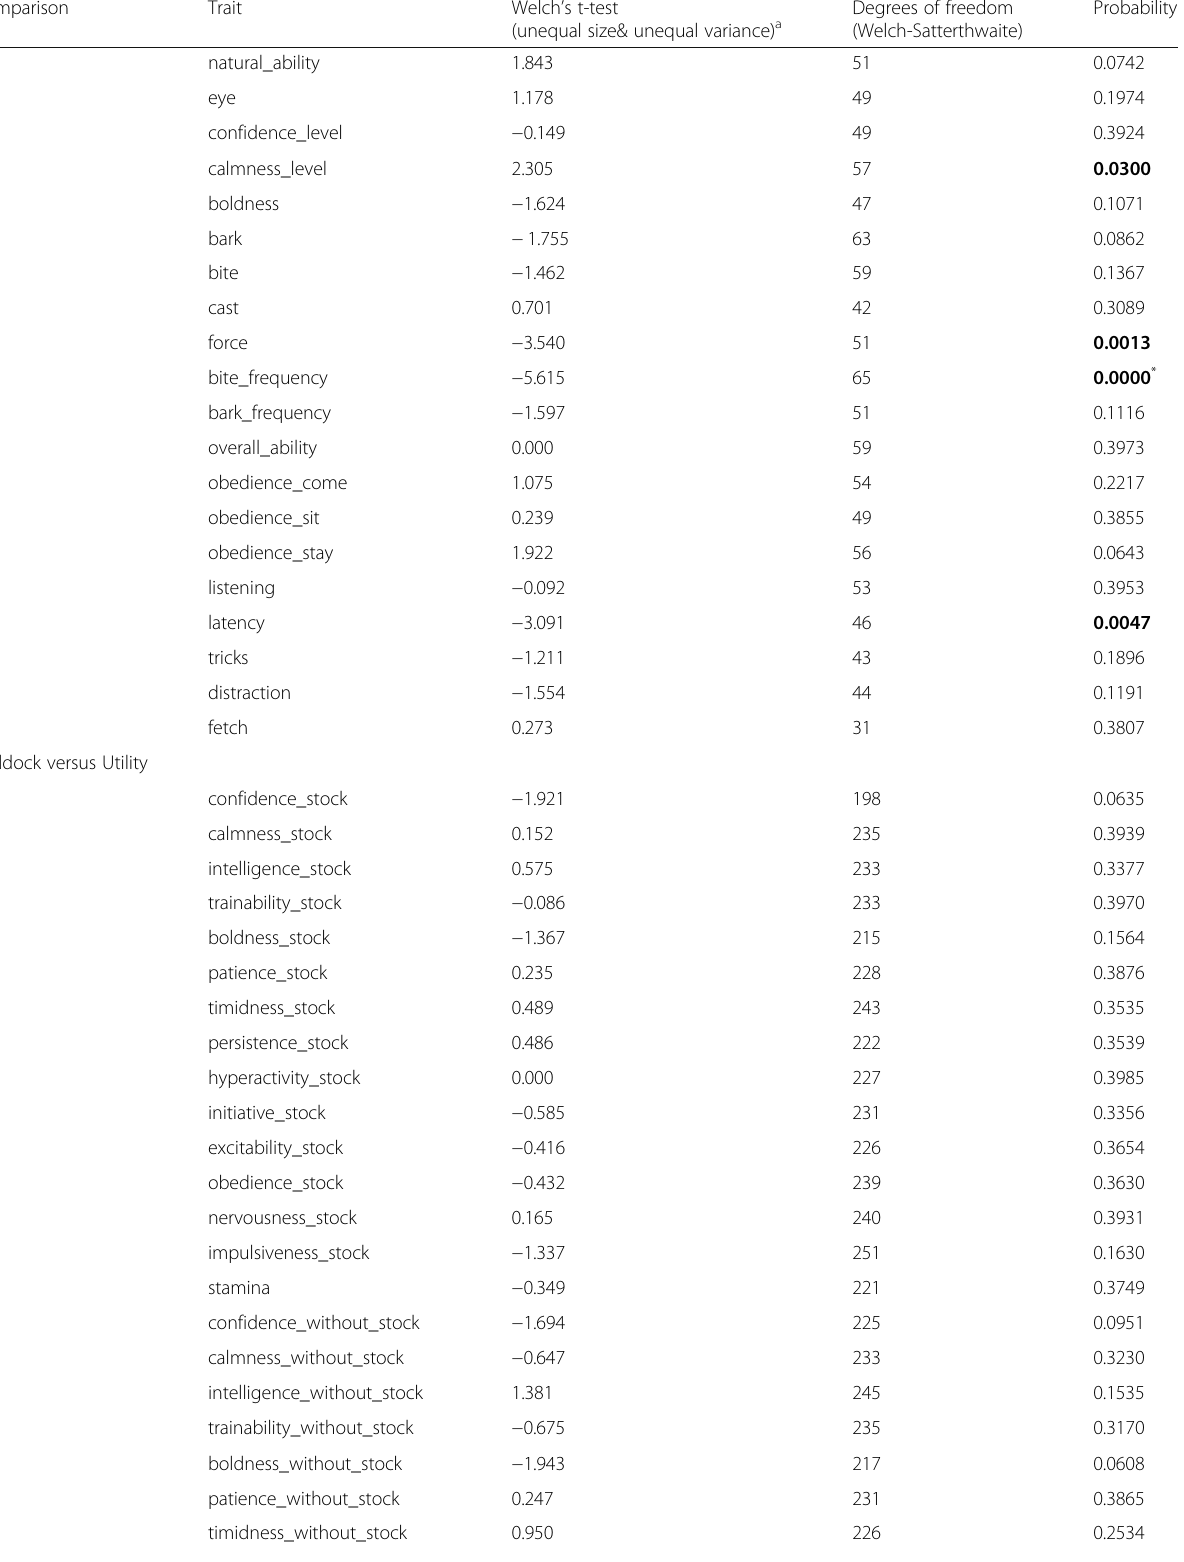
Table 1 Pairwise comparison of work-type in the Australian Working Kelpie over 63 traits (Continued)